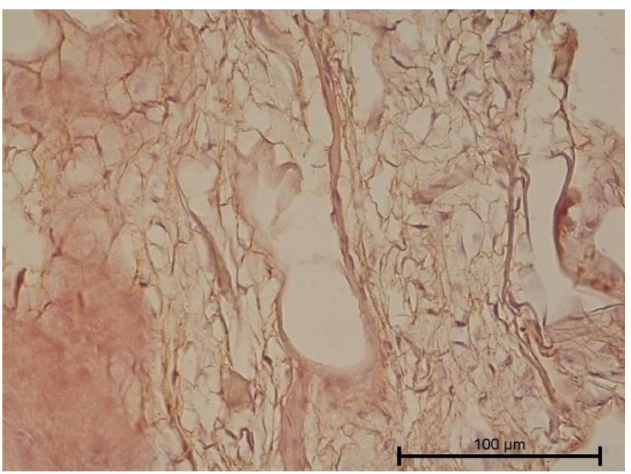
Figure 9. Light microscope image. Healthy tooth. Anti-PDPN—positive. Single infiltrating cells. Mag. 400 ×